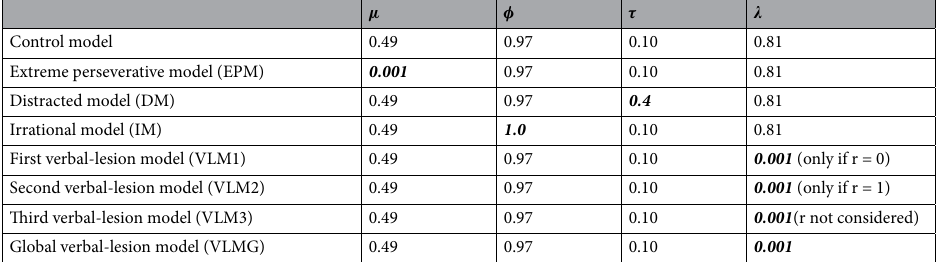
Table 4. Parameters of the lesioned models obtained by altering the parameters of the control model that fits the human control group (data reported in 47 ). The first three models involve lesions of the main cognitive processes of the model, while the last four models involve four different lesions of the language component. Values in bold Italics represent the parameters that were altered to produce the lesioned